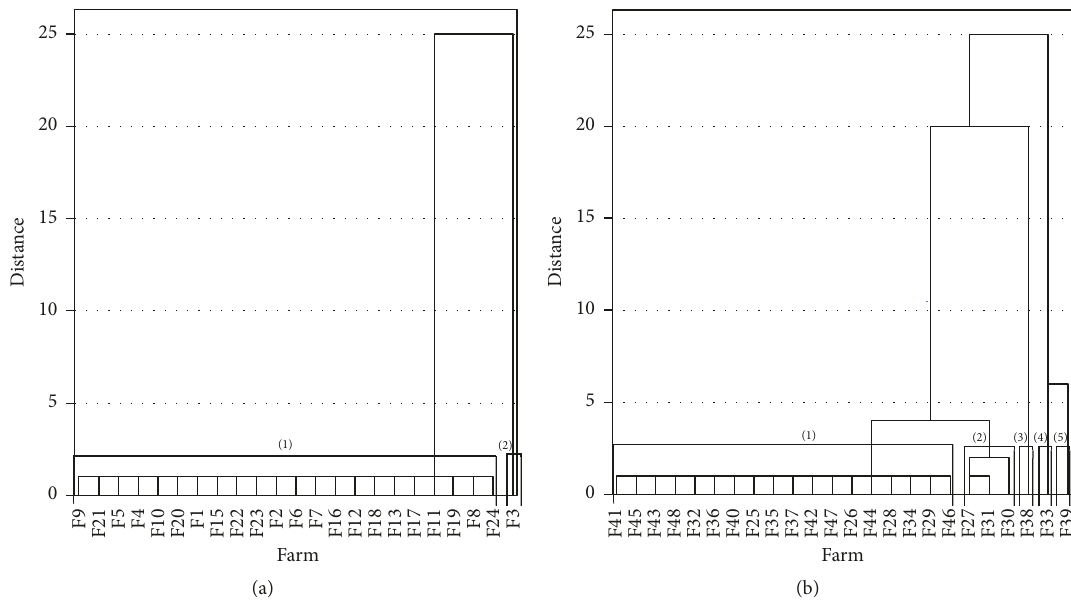
Figure 2: Agglomerative cluster analysis between the microorganism population density, percentage of colonization, and soil physicochem- ical parameters for cattle farms. (a) (1)-(2): farm groups related to parameters measured in Northern Antioquia (Colombia). (b) (1)–(5): farm groups related to parameters measured in Magdalena Medio, Antioquia